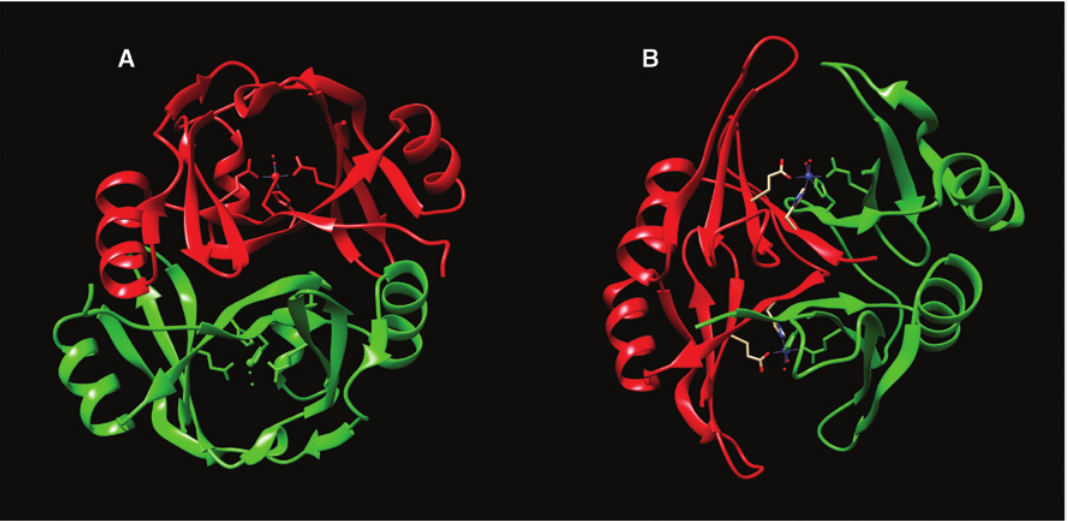
Figure 6: X-ray structure of Glo1 from Clostridium acetobutylicum (A) and Glo1 from Escherichia coli (B). Note the close similarities in their active sites but the orientation differences of the two subunits between the two enzymes. (PDB: 3HDP and 1F9Z).